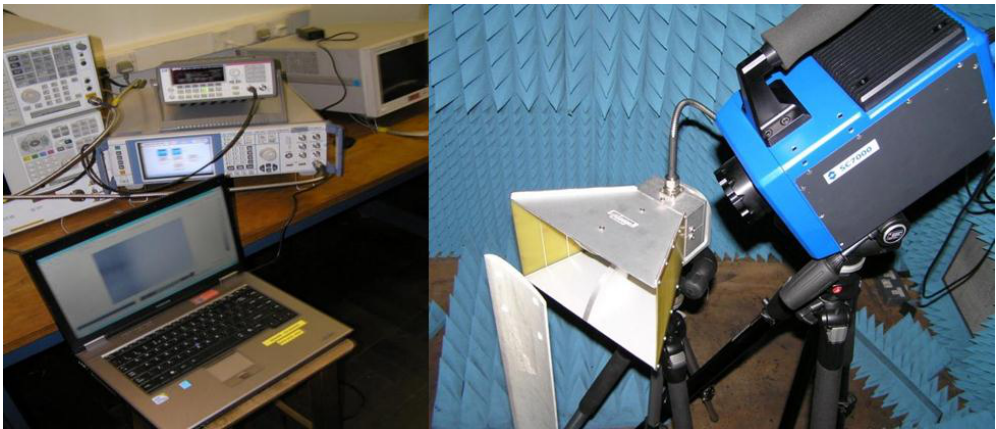
Figure 12. Experimental setup for defect detection with MWT.